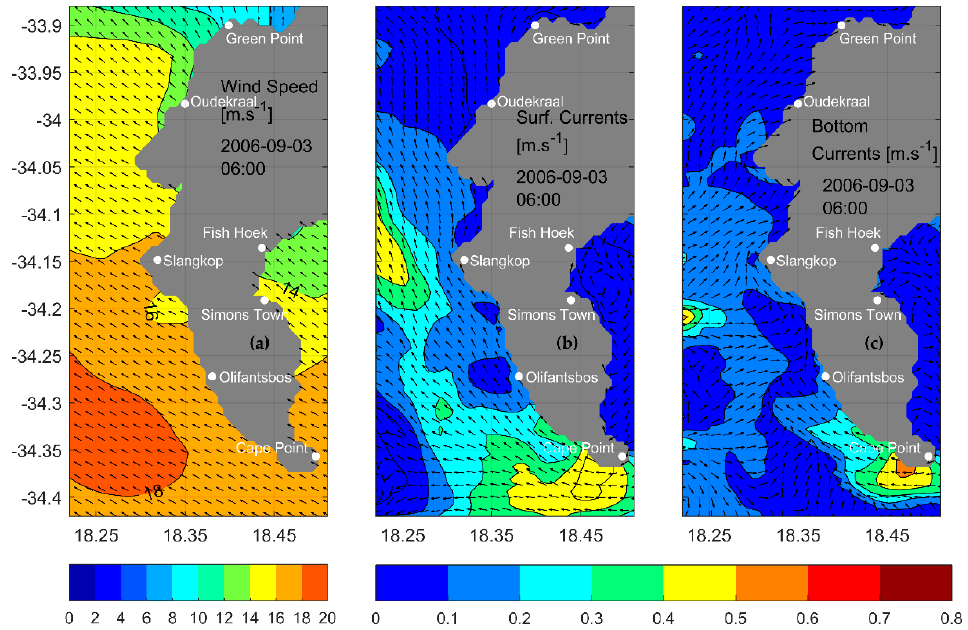
Figure 7. Near-surface ( b ) and bottom ( c ) flows near the Cape Peninsula under strong south-easterly wind conditions ( a ).